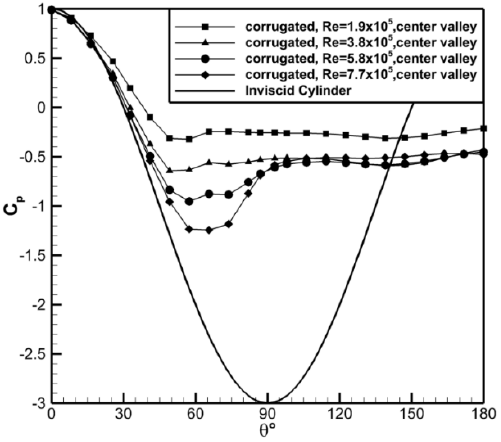
Figure 8. Pressure distributions through the corrugated cylinder center channel valley.